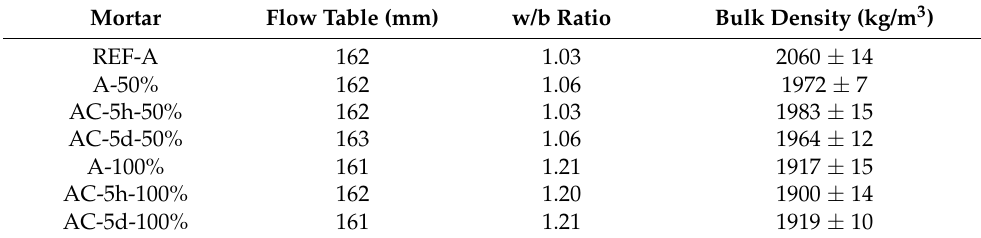
Table 4. Mortars’ flow table consistency, water/binder ratio and bulk